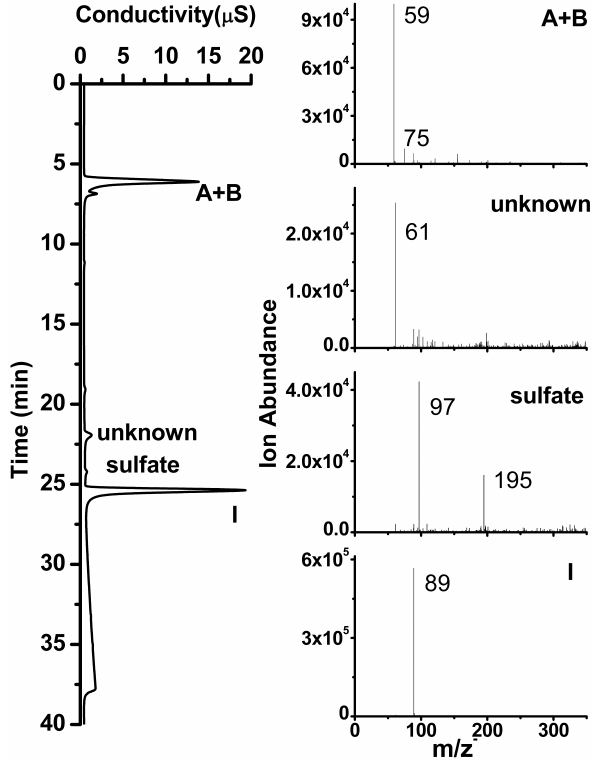
Fig. 2. IC-ESI-MS spectrum of a sample taken from 1mM acetic acid+OH radical batch reactions (120min reaction time). A+B has the retention time of acetic acid ( m/z − 59), glycolic acid ( m/z − 75) and formic acid (not an expected product, not detected in ESI- MS because its molecular weight is smaller than 50). m/z − 61 la- beled “unknown” is probably carbonate. m/z − 97 and 195 with the IC retention time of sulfate suggests that sulfate is a low- concentration contaminant; the area of this peak does not change over the course of the experiment. (I) oxalic acid ( m/z −